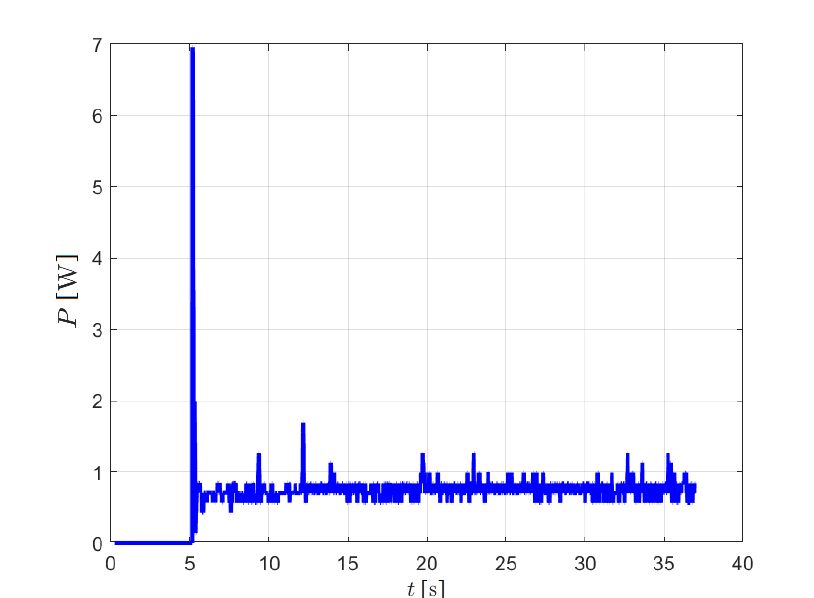
Figure 37. Power P during Map 1 run for the RRT star algorithm of the robot.